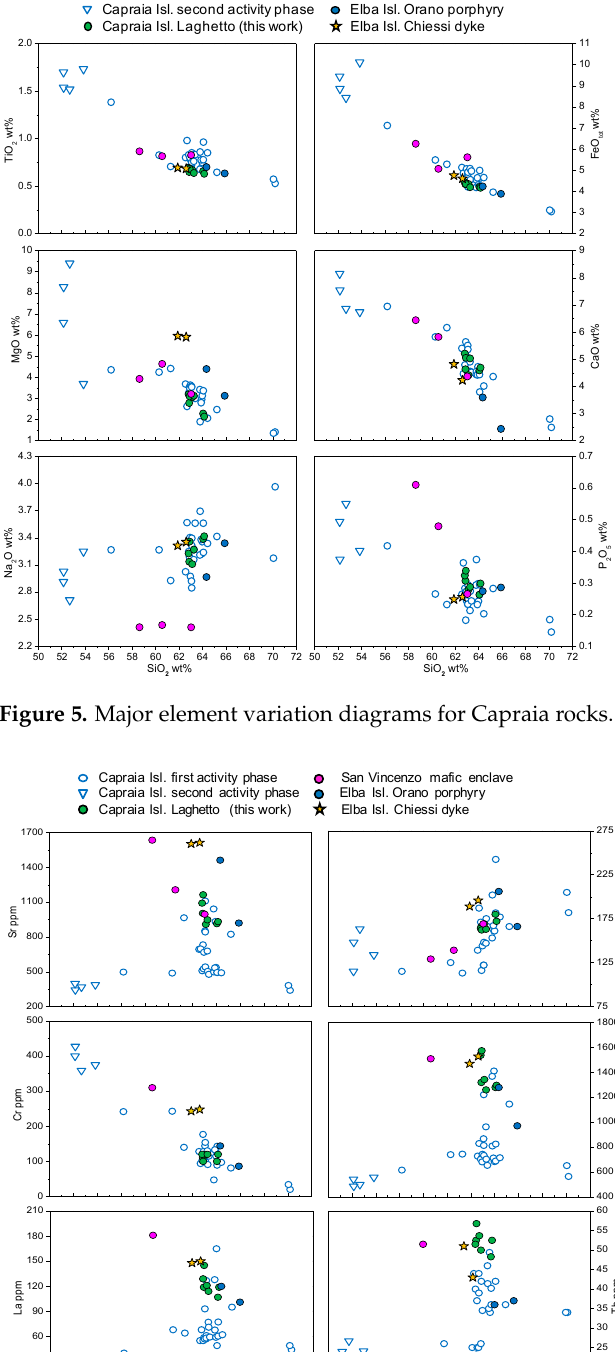
Figure 4. ( a ) TAS and ( b ) K 2 O vs. SiO 2 classification diagrams for Capraia rocks. Open circles (first activity phase) and triangles (second activity phase): data from the literature [9,28]; full green circles: this work. Some Elba dykes [15,35] and mafic enclaves from San Vincenzo [16,34] are also plotted for comparison. Data are plotted on water-free basis.